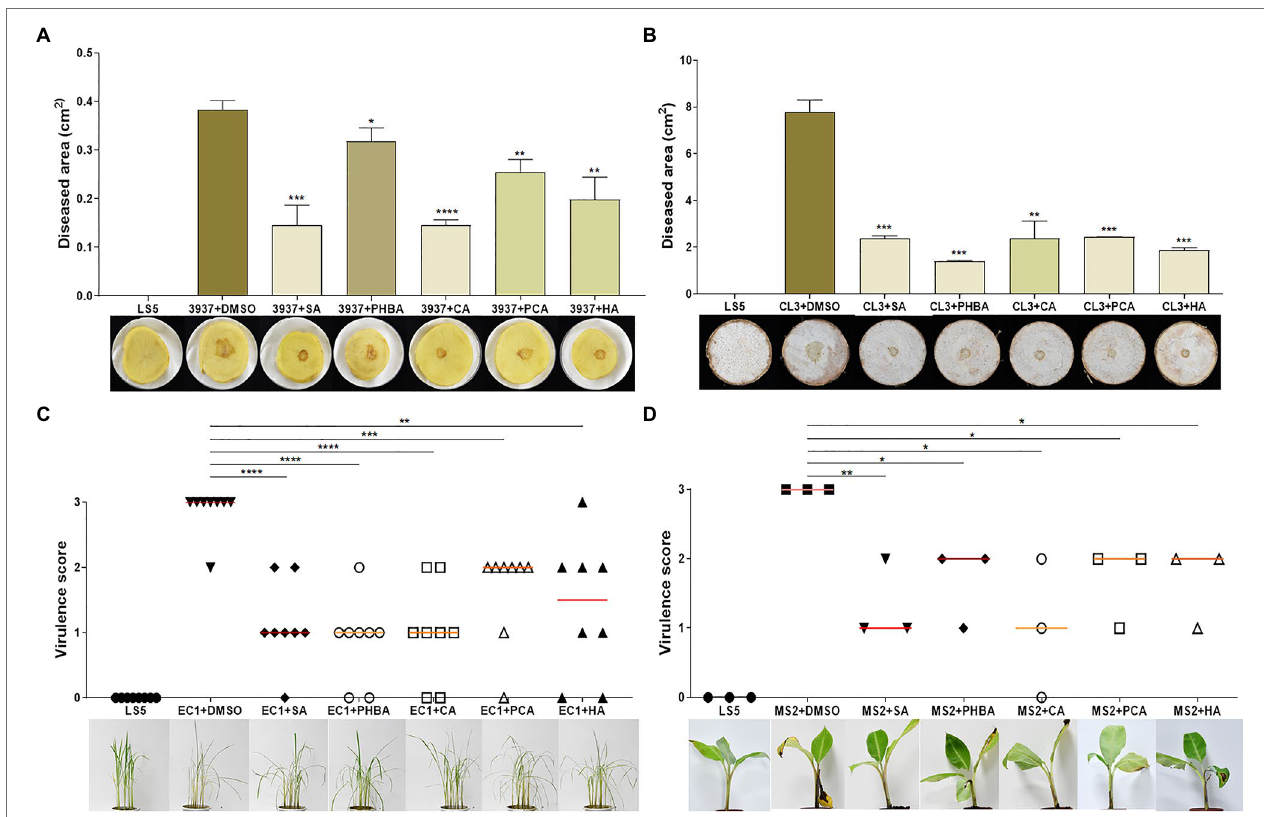
FIGURE 6 | Inhibition of SA (0.15 mM), PHBA (0.4 mM), CA (0.2 mM), PCA (0.2 mM), and HA (0.5 mM) against crop soft rot disease on potato (A) , taro (B) , rice (C) , and banana (D) . Cell suspensions of Dickeya dadantii 3937, D. fangzhongdai CL3, D. oryzae EC1, and D. zeae MS2 at OD 600 of 1.0 were incubated in the dark with optimal concentrations of the tested compounds or DMSO for 4 h. About 2 μ l (9.6 × 10 4 CFU) of D. dadantii 3937 and 5 μ l (2.4 × 10 5 CFU) of CL3 bacterial cells were respectively applied on the center of potato and taro slices, 500 μ l (2.4 × 10 7 CFU) of MS2 bacterial cells were injected into the pseudostems of banana seedlings, and 175 ml (4.8 × 10 9 CFU) of EC1 bacterial cells were irrigated into pots with rice seedlings after needle punctures on stem bases. Three potato slices, taro slices, and banana seedlings, and eight rice seedlings were inoculated each time, and three independent tests were performed with similar results. MS2 + DMSO was used as the positive control. The data were subjected to Student’s t -test analysis by Graphpad Prism 8.4.3 (ns, no statistical significance, * p < 0.05, ** p < 0.01, *** p < 0.001, and **** p <